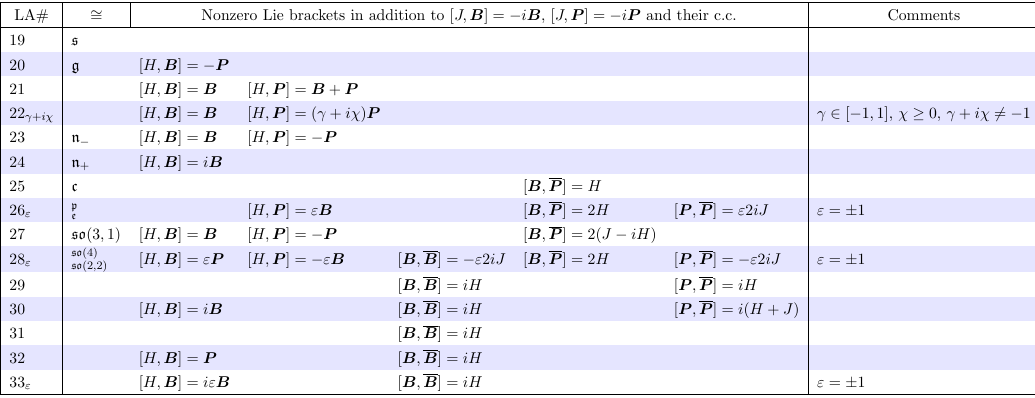
Table 8 . Kinematical Lie algebras for D = 2 (complex